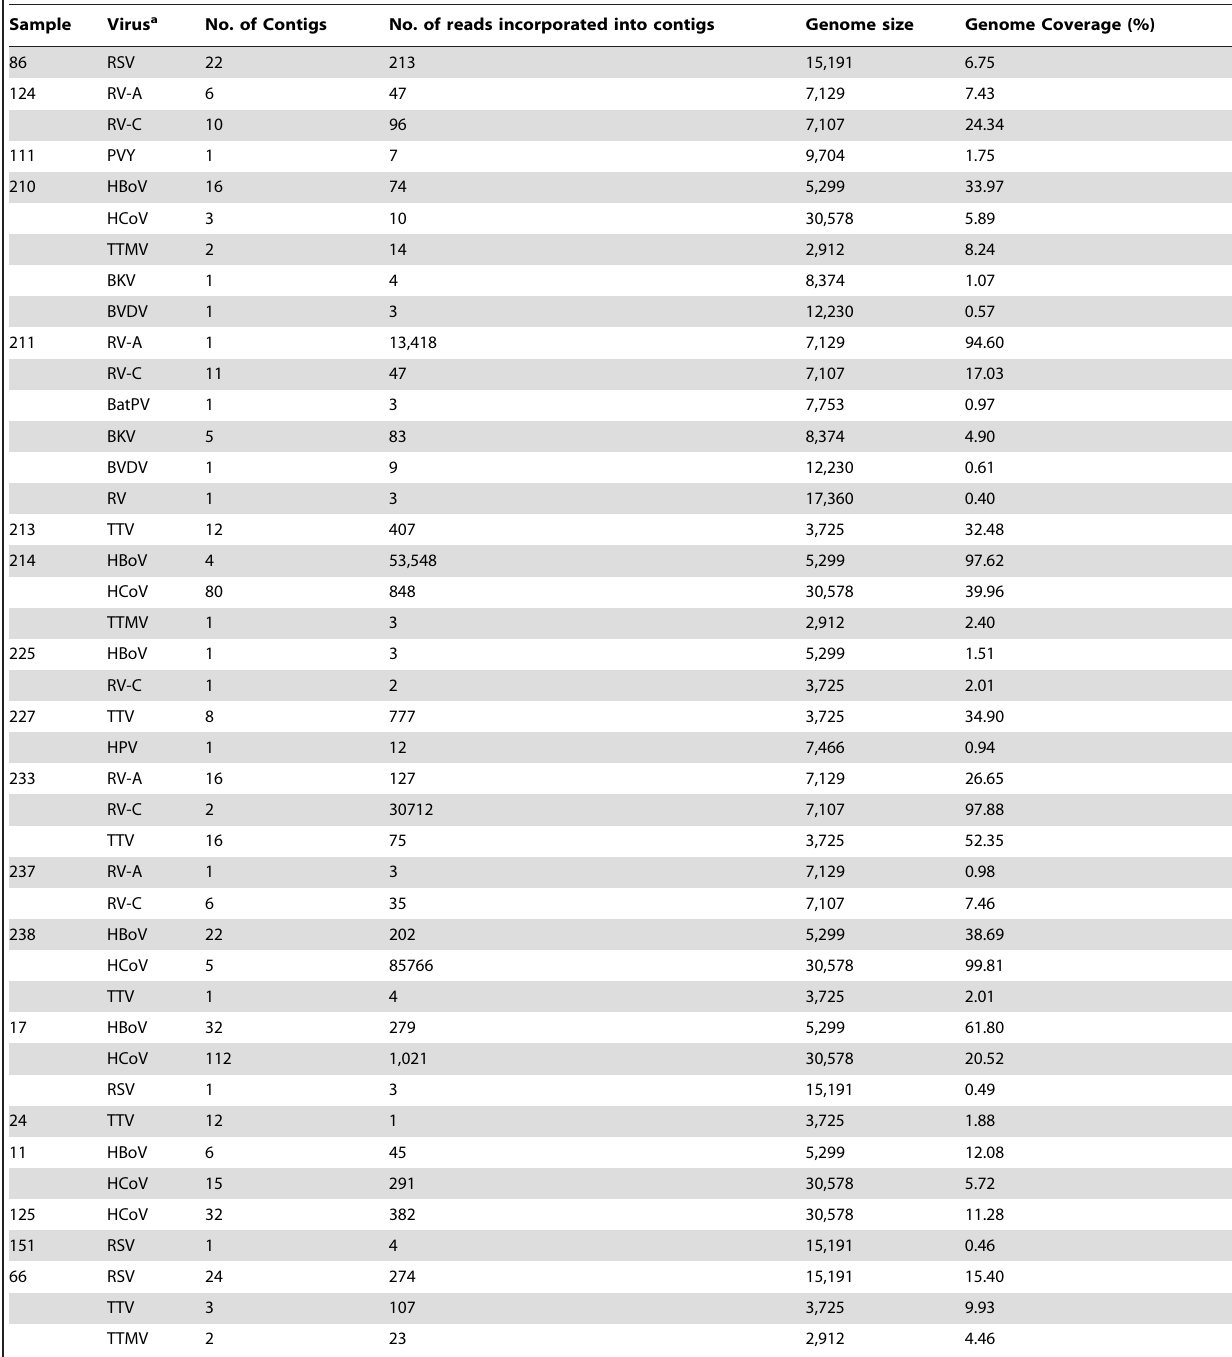
Table 6. Genome coverage for viruses present in LRTI samples.